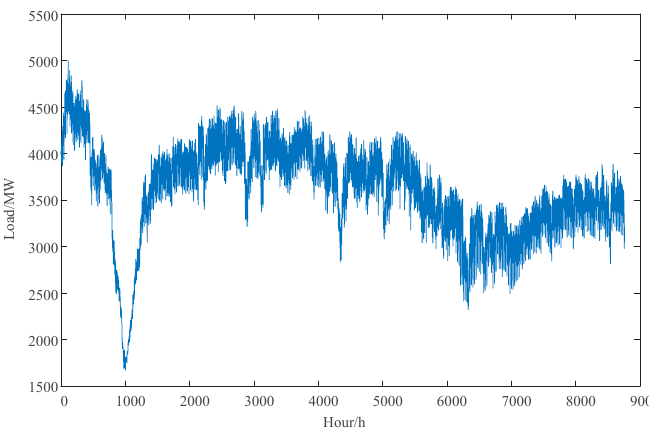
Figure 1. The annual hourly power load of industrial users.